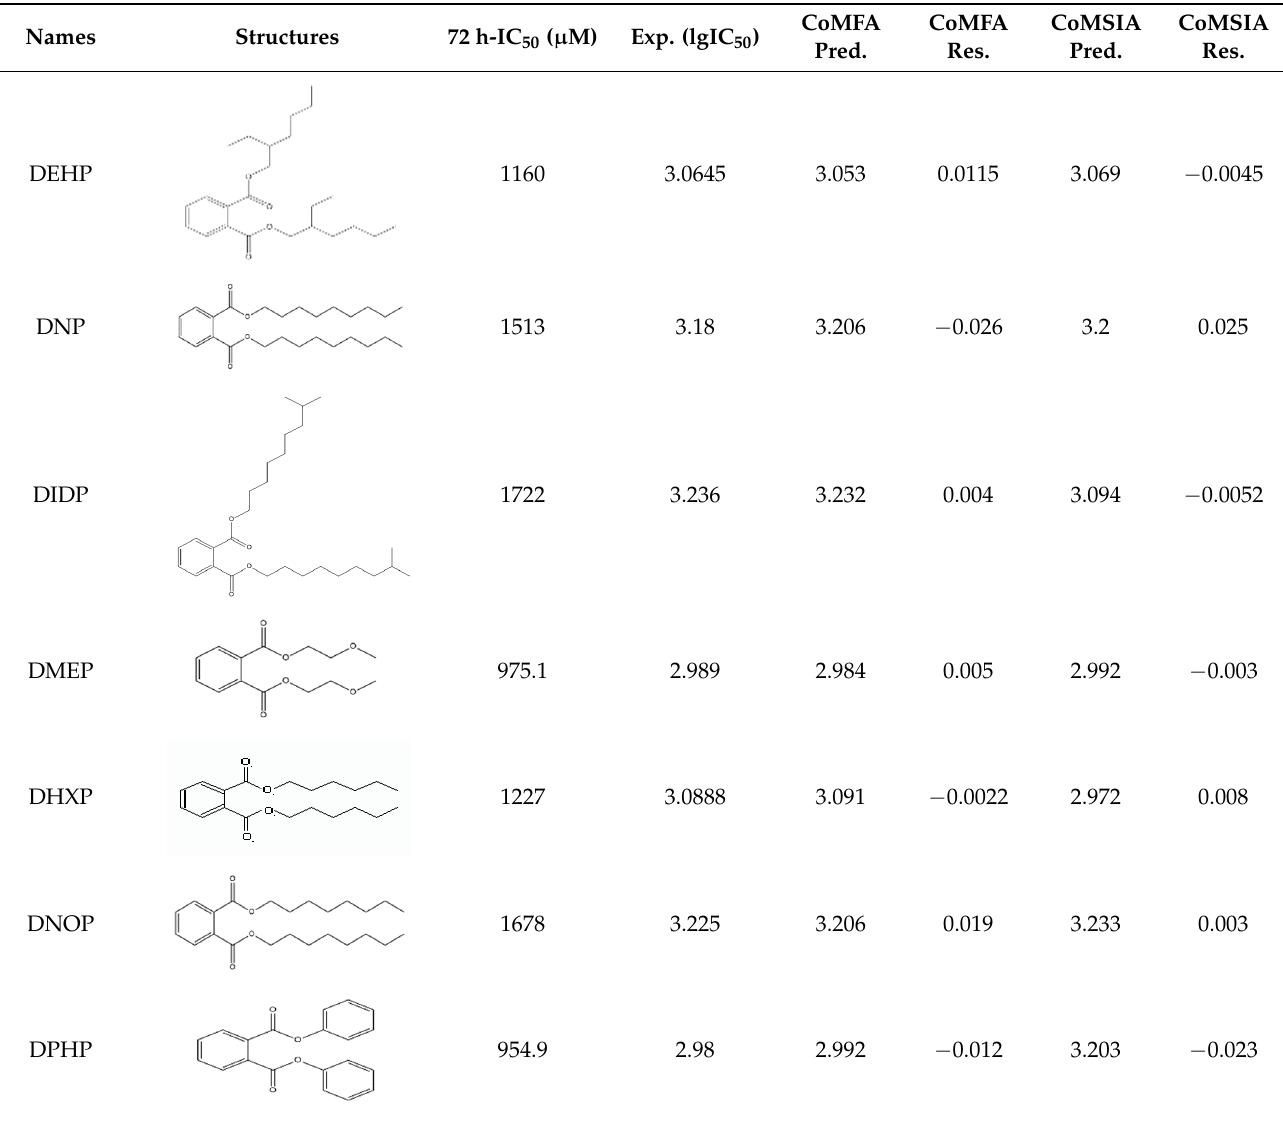
Table 3. Actual value, predicted value and error of 3D-QSAR model of PAEs 72 h-lgIC 50 . Structures